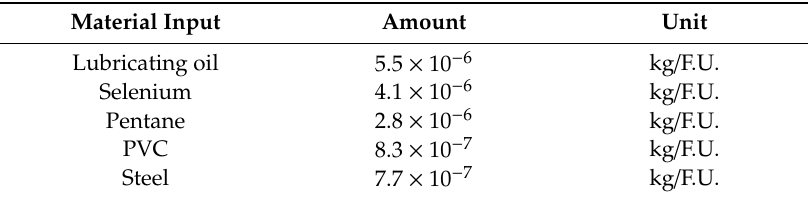
Table 5. Main material and energy inputs employed in the maintenance phase. The cut-o ff is set 2% of the total mass, to reduce the number of inputs reported. Complete information can be found in the Supplementary Materials.